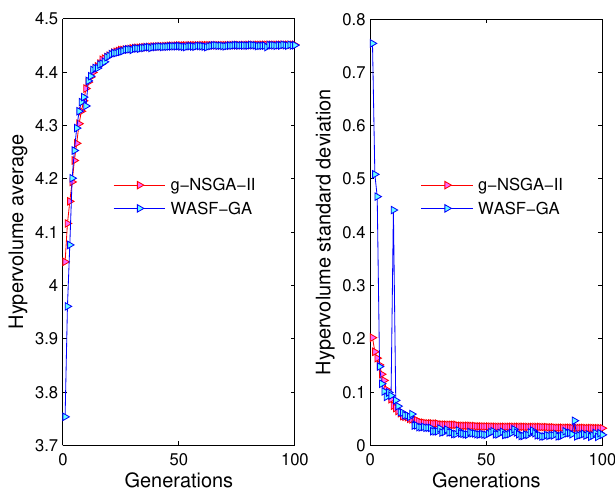
Figure 9. Box-plots based on the hypervolume metrics ( 4,0.003 ) ( left ), ( 15,0.0025 ) ( middle ) and ( 30,0.001 ) ( right ) for g-NSGA-II and WASF-GA ( N = 100).